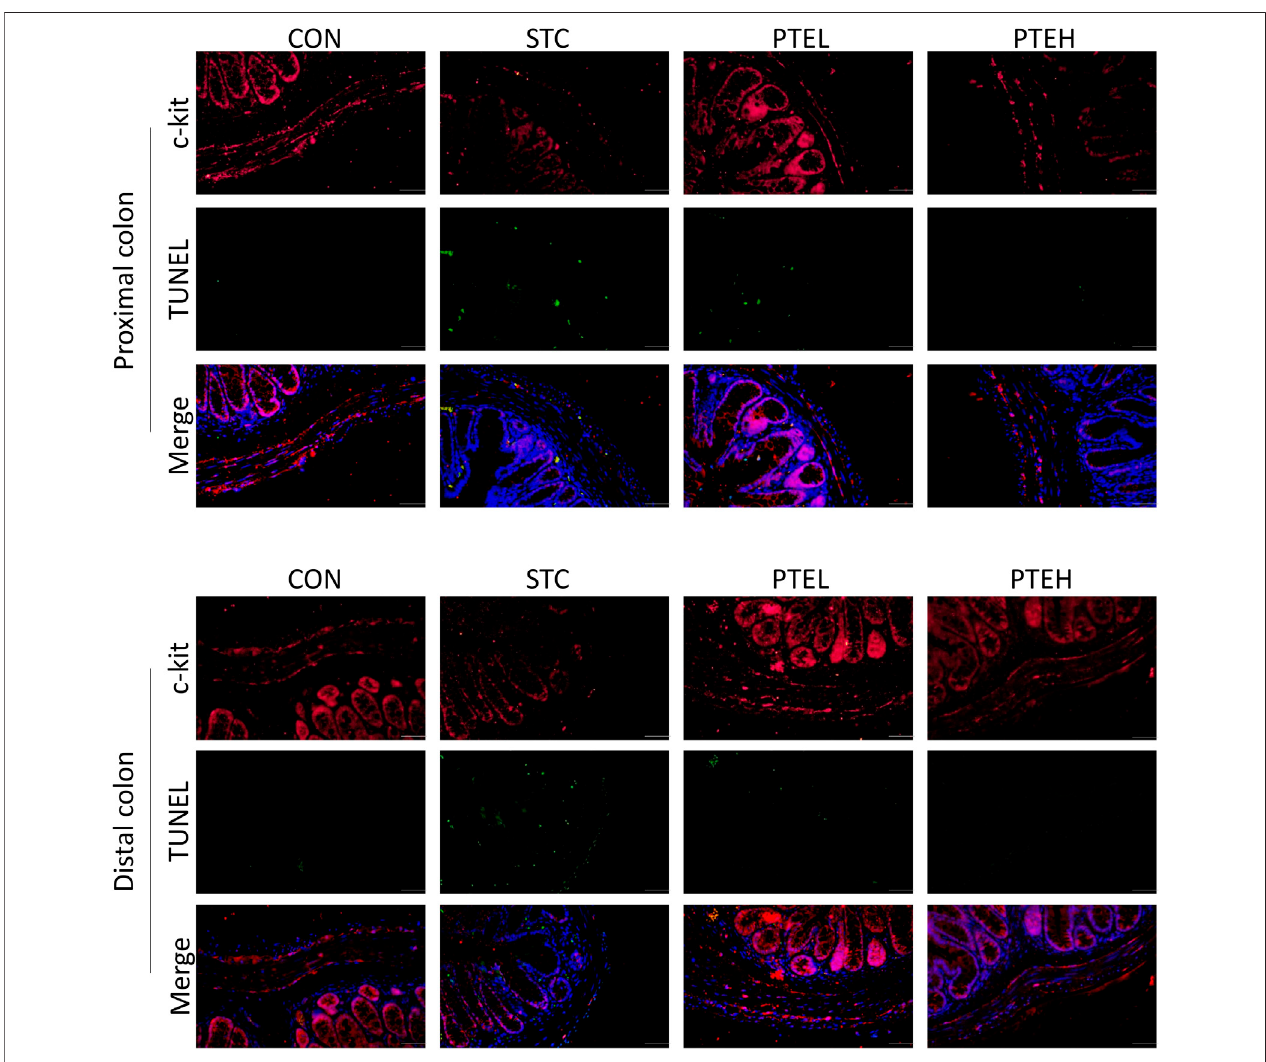
FIGURE 2 | Images of cross-sections showing the alteration of the apoptosis of interstitial cells of Cajal (ICCs) in the colon. c-kit positive ICCs were stained in red and TUNEL positive ICCs were stained in green, cell nuclei were labeled with DAPI (blue). ( n = 3 in each group). Scale bar = 100 μ m.